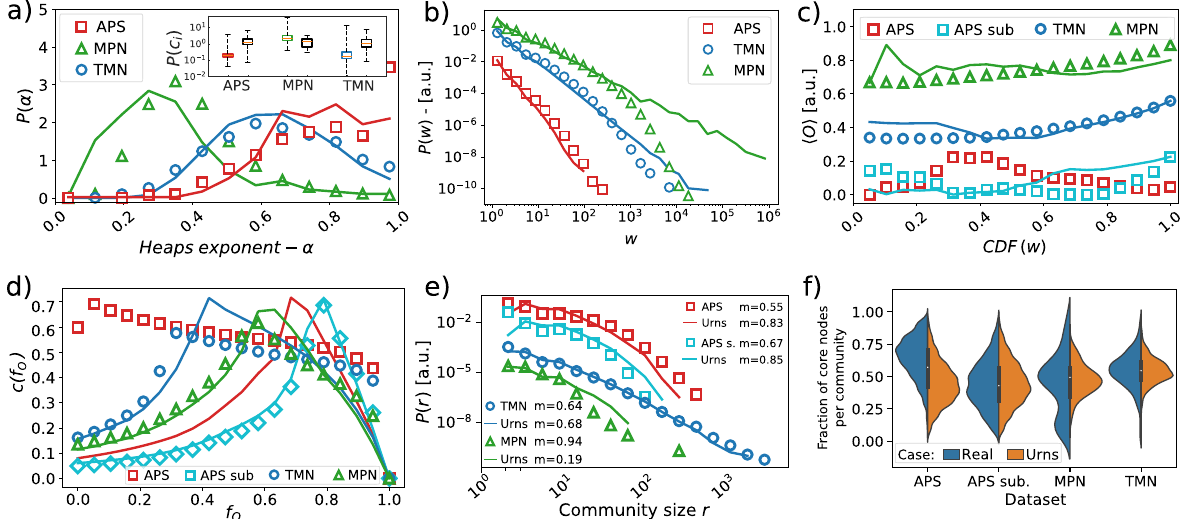
Fig. 5 Topological properties of social networks: empirical data and model predictions. In all the panels, we show the data of the empirical datasets using symbols and data from the synthetic simulations with solid lines. To distinguish the datasets, we use the red colour for American physical society (APS), cyan for the APS 1-link subsample dataset, green for the mobile phone network, and blue for the Twitter mentions network dataset. a The P ( α ) distribution of the local Heaps ’ exponent α for a sample of 10% of nodes as measured in the empirical networks and the simulated ones. In the inset, we show the P ( c i ) distribution of the individuals ’ strengthening constant c i as measured in empirical data (coloured boxes) and their corresponding simulations (black boxes). b The P ( w ) link weight distribution for the three empirical datasets (symbols) and the ones found in the arti fi cial networks (solid lines). c The average overlap in the network obtained by removing edges in ascending order of weight up to a given cumulative density function value (percentile). d The average clustering coef fi cient c ( f O ) measured on the network obtained by removing edges being in the overlap percentiles O ≤ f O . e The distribution P ( r ) of the community sizes r found in the different datasets. In the legend, we show the network modularity m as measured in each dataset. f The distribution of the fraction of core nodes within the communities of the different networks. We compare the empirical results (blue distributions on the left) with the synthetic ones (orange areas on the right, the dataset names are reported on the x